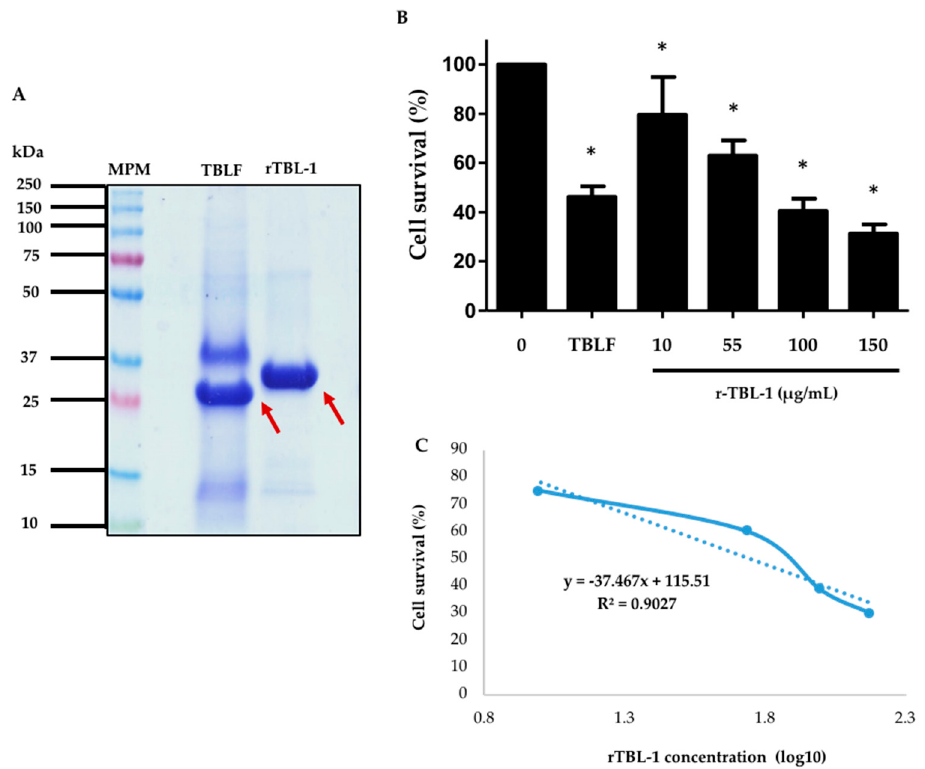
Figure 7. Comparison between the recombinant lectin and native lectin and cytotoxic effect of rTBL-1 on HT-29 colon cancer cells. ( A ) SDS-PAGE. Molecular weight marker, MPM; Tepary bean lectin fraction, TBLF; rTBL-1. Arrows point to both the native and recombinant lectins. ( B ) Dose–response curve after 8 h treatment with rTBL-1. TBLF treatment corresponds to its LC 50 . ( C ) Concentration-response curve. The experiment was carried out in four independent assays. The asterisks (*) show significant differences between each rTBL-1 concentration with respect to the control ± S.D. (Dunnett, p ≤ 0.05).